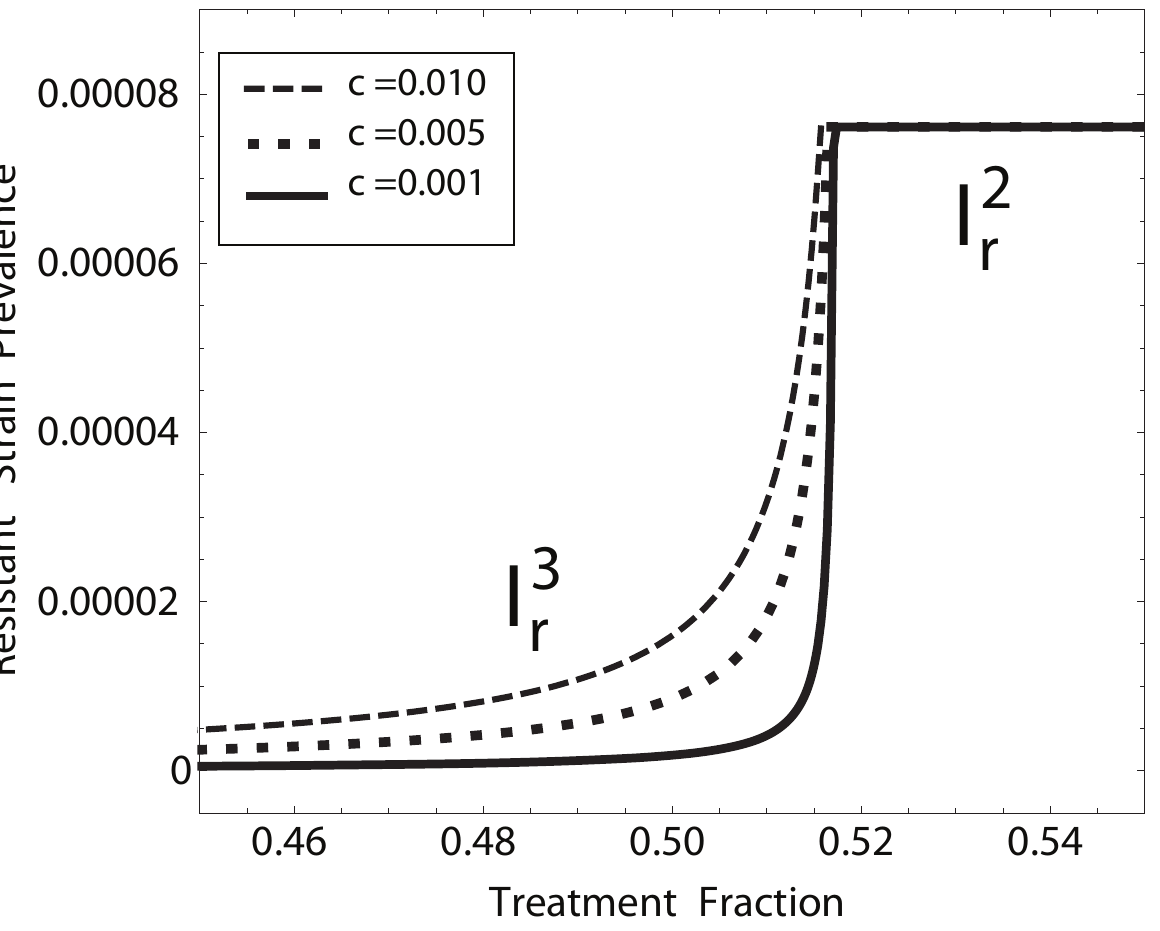
Figure 5. Resistant strain prevalence vs. treatment fraction. Smaller c leads to more abrupt transitions from wild-type to resistant strains. Larger c renders r (cid:3) ineffective as a treatment regime.